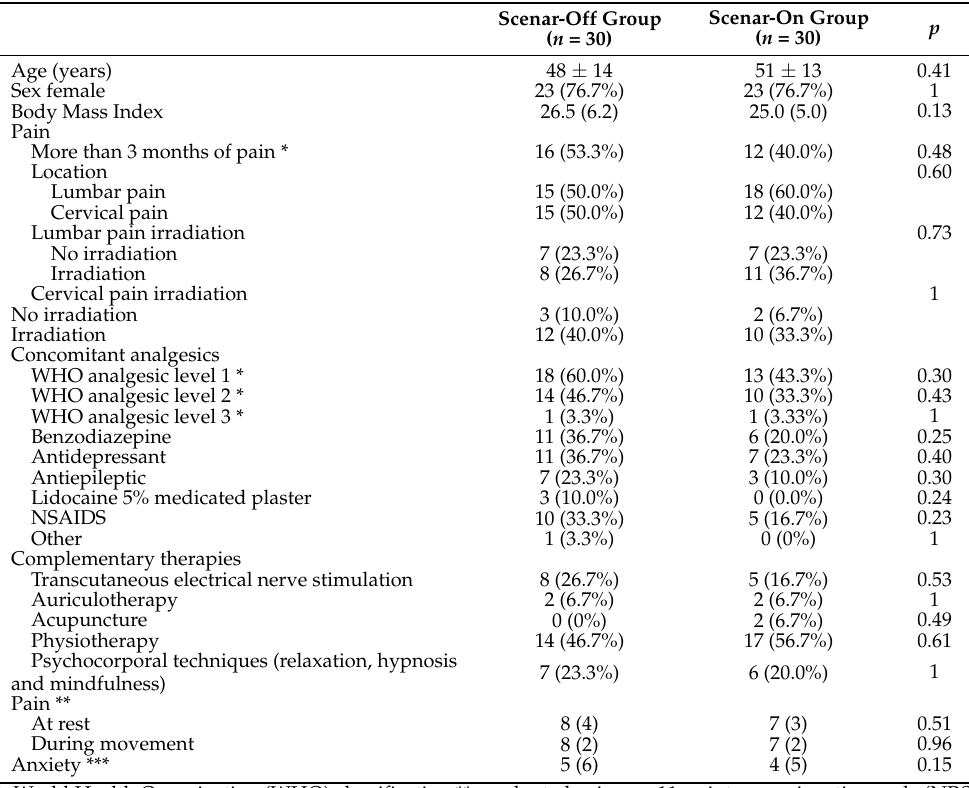
Table 1. Patients’ characteristics at baseline.